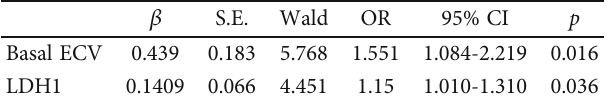
Figure 3: The comparison of biochemical parameters between patients with or without heart failure. (a) ALB (heart failure, n = 30 ; nonheart failure, n = 21 ). (b) β 2-MG (heart failure, n = 30 ; nonheart failure, n = 21 ). (c) Creatine Kinase-MB (CK-MB) (heart failure, n = 30 ; nonheart failure, n = 21 ). (d) hs-TNI (heart failure, n = 30 ; nonheart failure, n = 21 ). (e) pro-BNP (heart failure, n = 30 ; nonheart failure, n = 21 ). (f) End-diastolic volume (EDV)-CF/BAS (heart failure, n = 30 ; nonheart failure, n = 21 ). (g) End-systolic volume (ESV)-CF/BAS (heart failure, n = 30 ; nonheart failure, n = 21 ). (h) Myocardial mass (CF/BAS) (heart failure, n = 30 ; nonheart failure, n = 21 ). (i) Basal ECV (heart failure, n = 30 ; nonheart failure, n = 21 ). (j) Apical ECV (heart failure, n = 30 ; nonheart failure, n = 21 ). (k) Mid ECV (heart failure, n = 30 ; nonheart failure, n = 21 ). (l) Left ventricular ejection fraction (LVEF) (heart failure, n = 30 ; nonheart failure, n = 21 ). Table 2: Multivariate logistic analysis of cardiac